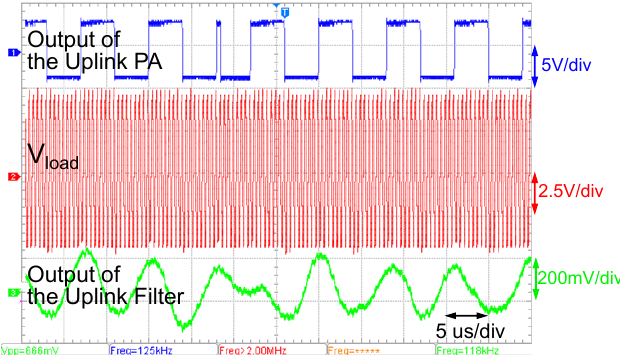
Figure 14. Waveforms in our prototype when the coil separation is 20 mm.